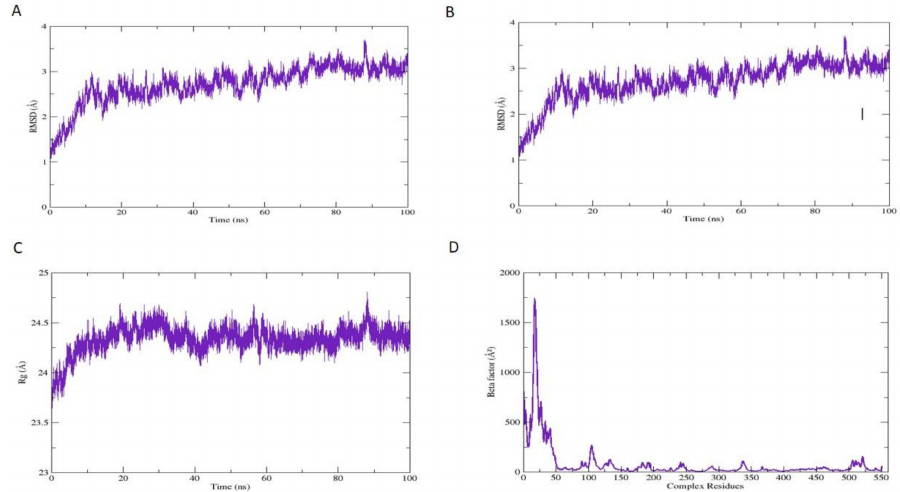
Figure 7. Root means square deviation (RMSD) of COX-2 protein and Methyl 7-abieten-18-oate complex ( A ) in-unit Angstrom (Å) is shown at Y-axis, while the variation in bonded conformation through time in nanoseconds (ns) is shown at X-axis. Root Mean Square Fluctuation (RMSF) of protein COX-2 ( B ) in-unit Angstrom (Å) is shown at the Y-axis, while the X-axis shows the index of the residue during 0–100 ns. The radius of gyration (Rg) of protein and COX-2 inhibitor complex ( C ) is shown at Y-axis in-unit Angstrom (Å), while X-axis shows the variation in bonded conformation throughout simulations. A beta factor of protein COX-2 ( D ) is shown at Y-axis in-unit Angstrom (Å), while X-axis shows the index of the residue until 100 ns.